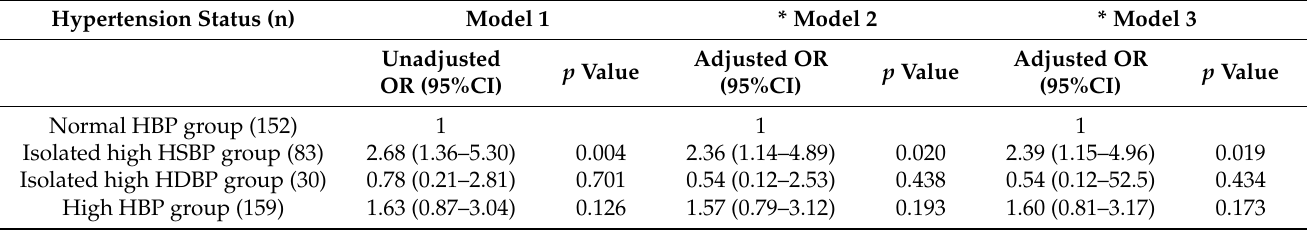
Table 3. Unadjusted and adjusted odds ratios for the development of diabetic nephropathy.